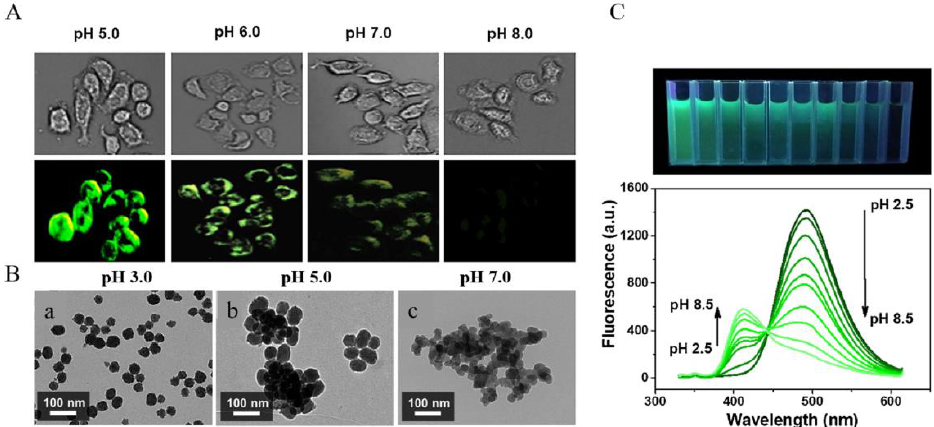
Figure 4. Under different pH levels: ( A ) CLSM images, ( B ) TEM of (a) pH=3.0 (b) pH=5.0 (c) pH=7.0 and ( C ) PL spectra [87]. Reprinted/adapted with permission from Ref. [87]. 2018, Elsevier.